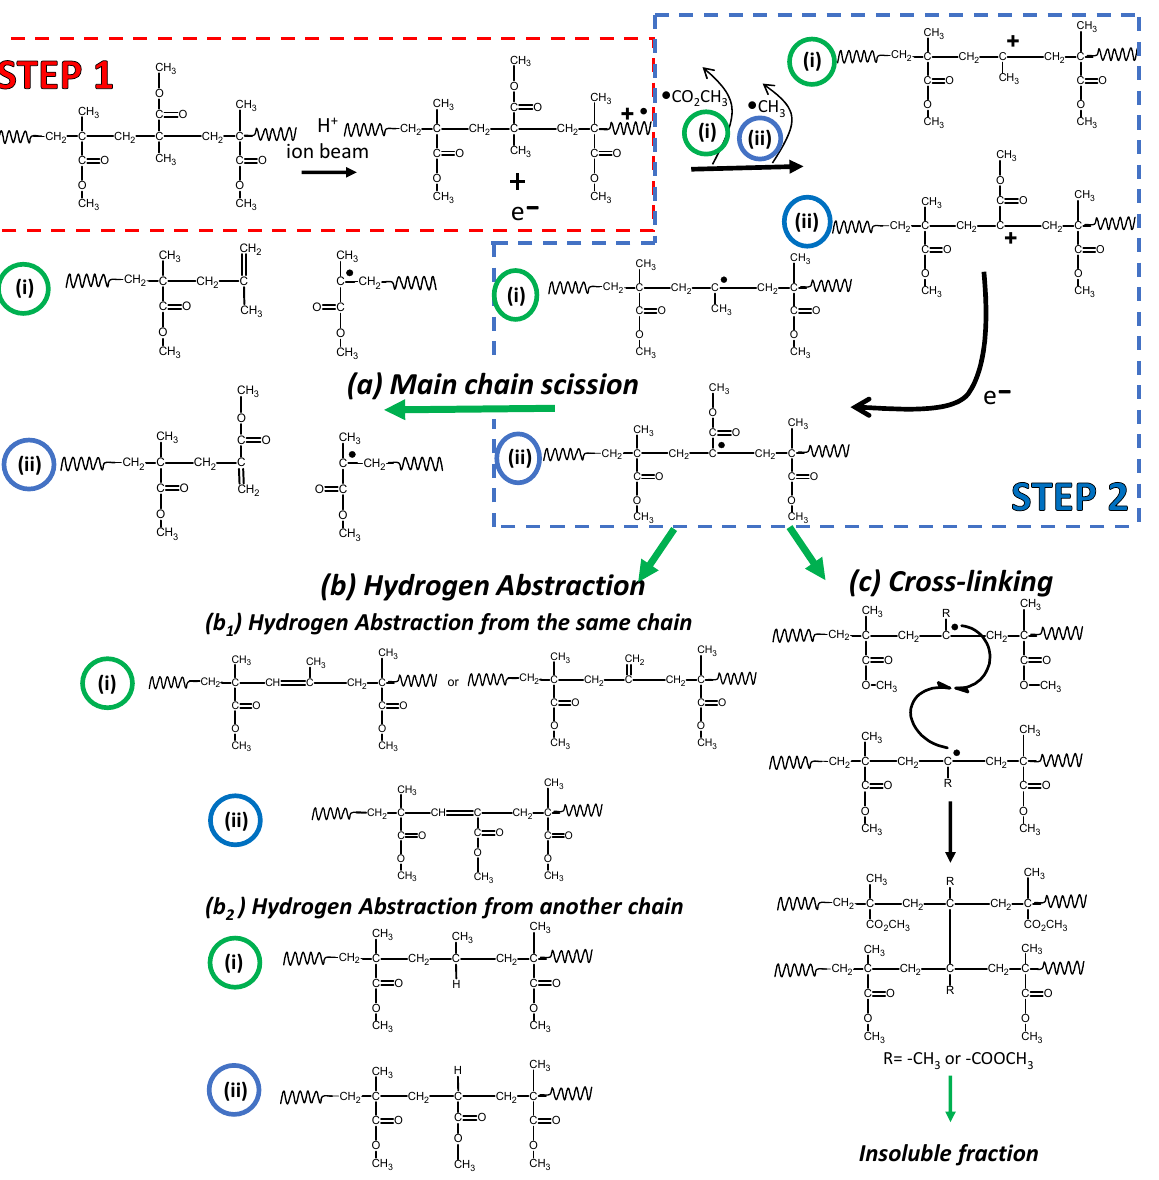
Scheme 1. Schematic representation of the reactions occurring during the H + ion-beam bombardment of PMMA.